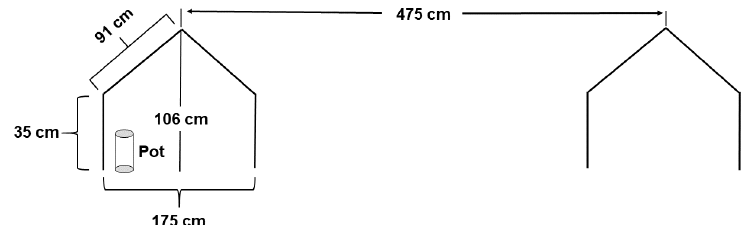
Figure 1. Pre-fabricated and modular mini-hoop structures used in this study to assess drought stress effects on morpho-physiological traits of rice genotypes. Pot: a polyvinyl-chloride plastic pot of 15.2-cm diameter and 30.5-cm height.